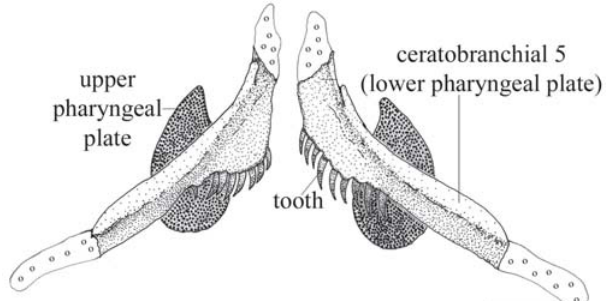
Fig. 23. Ventral view of the lower pharyngeal plate of Neoplecostomus ribeirensis (MZUSP 100920, 45.3 mm SL). Scale bar = 0.5 mm.